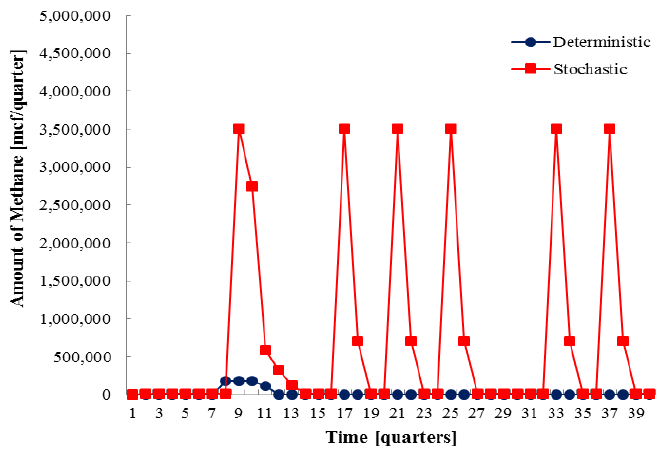
Figure 13. Total amount of natural gas sold in Market 1 for both deterministic (base case) and stochastic cases during the planning horizon.